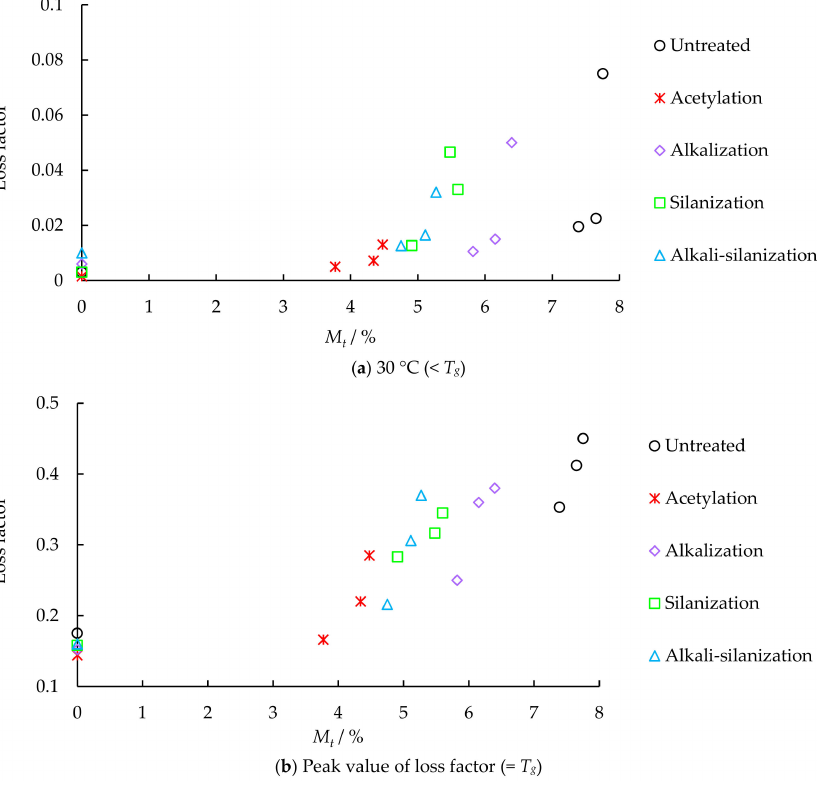
Figure 5. Relationship between loss factor and moisture